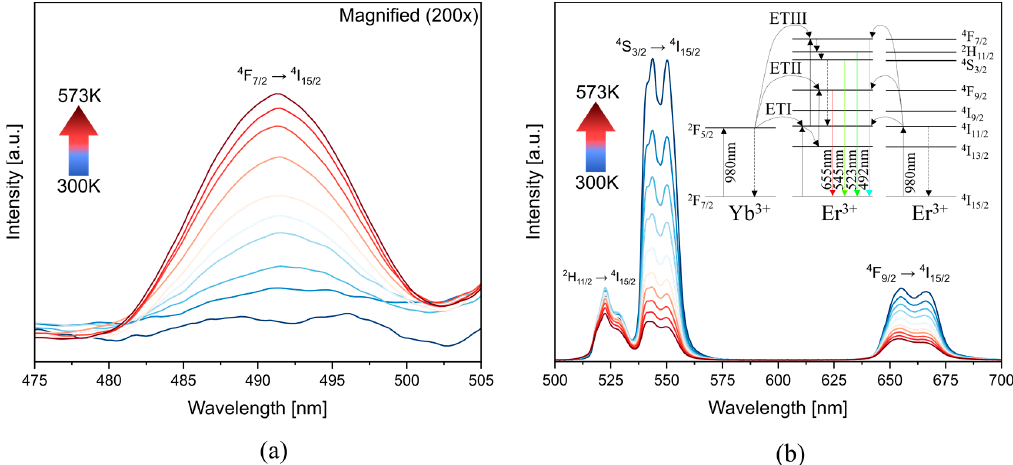
Figure 2. Emission spectra of fluoroindate glass co ‐ doped with Yb 3+ /Er 3+ under the 980 nm excitation at the ( a ) 475–505 nm range ( b ) 500–700 nm range (inset—Yb 3+ /Er 3+ energy scheme).